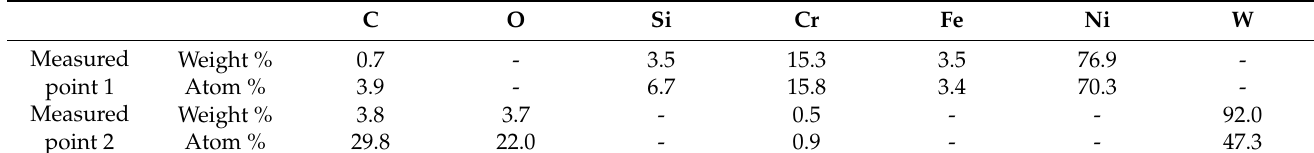
Figure 6. Microanalysis of powder particles ( a ) acquired SEM image of PE powder showing its morphology and measured points under analysis ( b , c ) Energy-dispersive X-ray spectrometry (EDS) diagrams of measured points 1 and 2. Table 5. Chemical composition in weight % and atom % of measured points of PE powder under analysis.